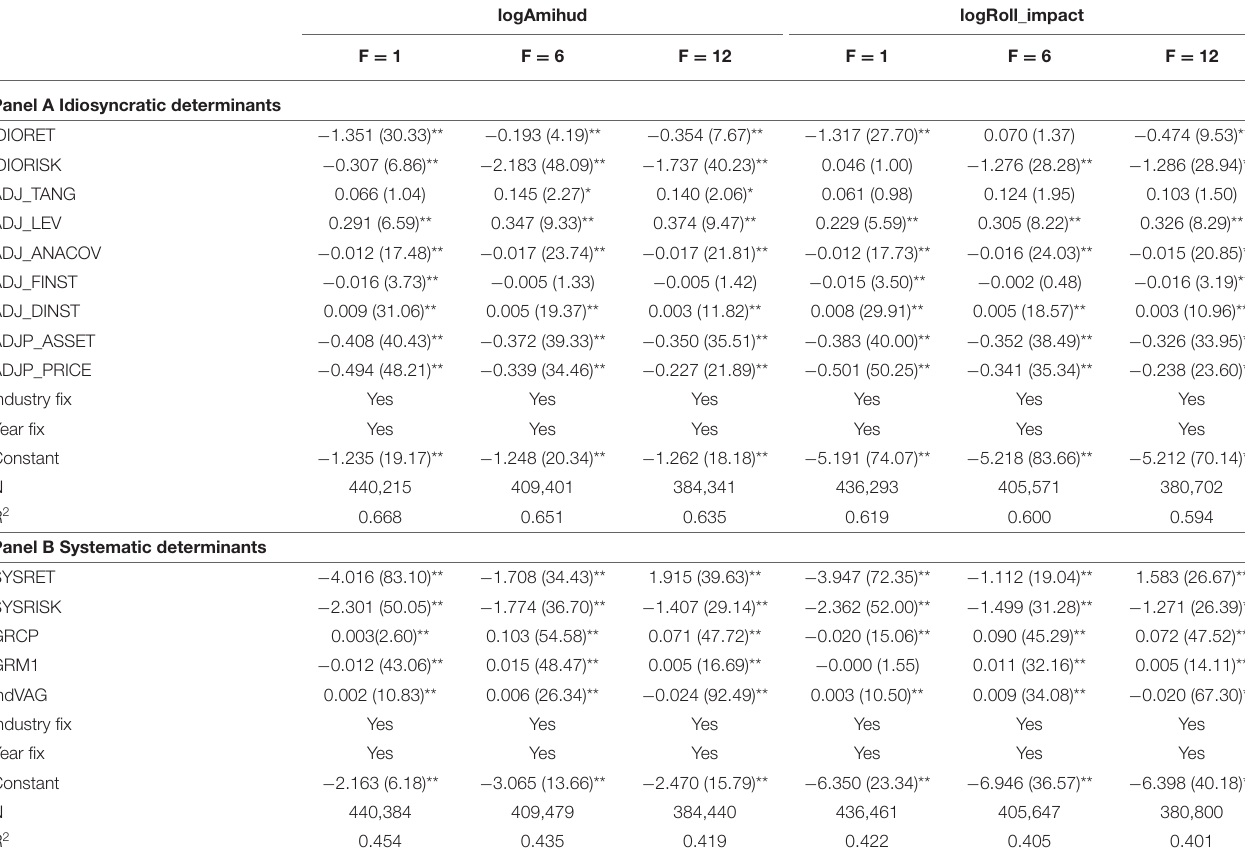
TABLE 5 | Future impact of variables on Amihud’s illiquidity ratio and Roll’s price impact. logAmihud